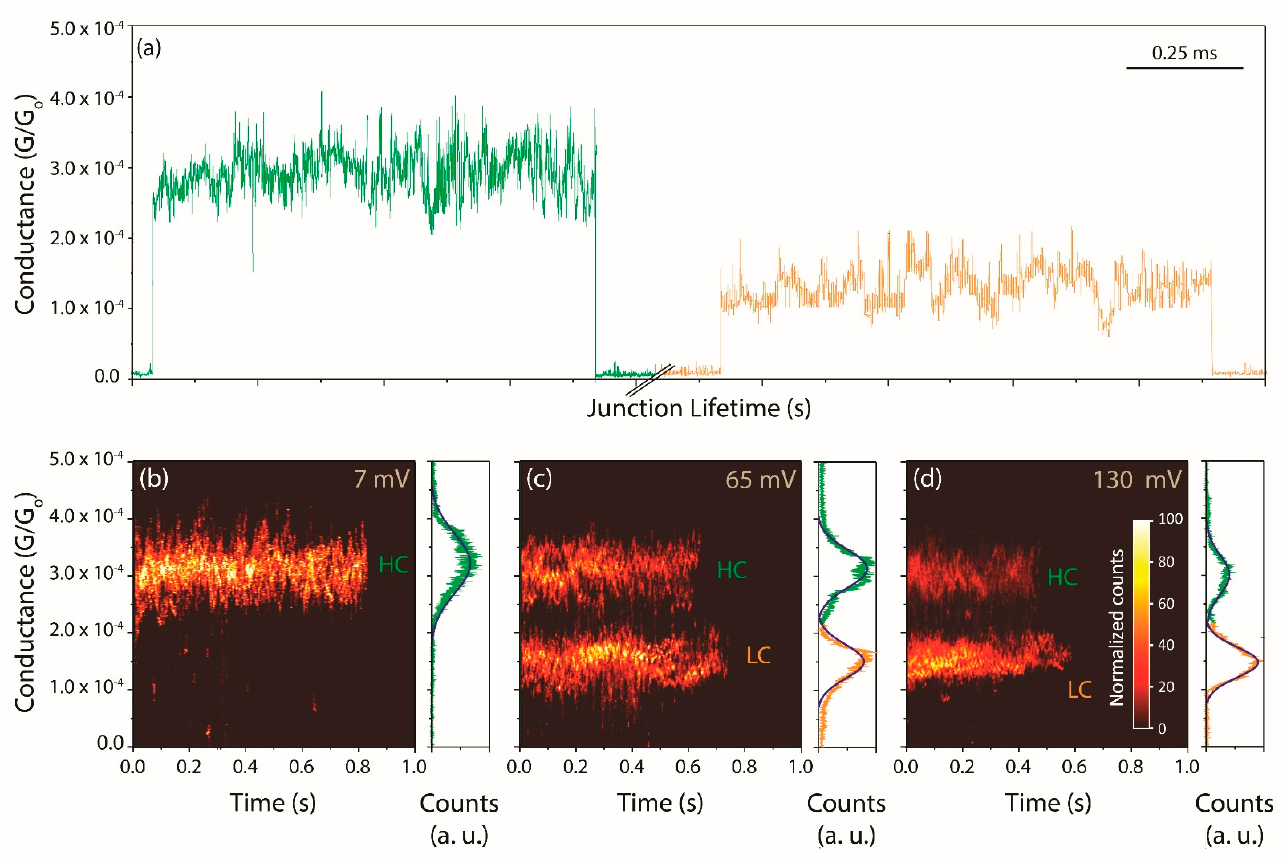
Figure 3. ( a ) Representative HC (green) and LC (orange) blinks of the trans-TMC junction formation in a typical static BJ experiment. 2D conductance maps built out of hundreds of trans-TMC blinking traces at V bias = ( b ) 7 mV, ( c ) 65 mV, and ( d ) 130 mV at a fixed gap distance. Counts are normalized to a maximum of 100.